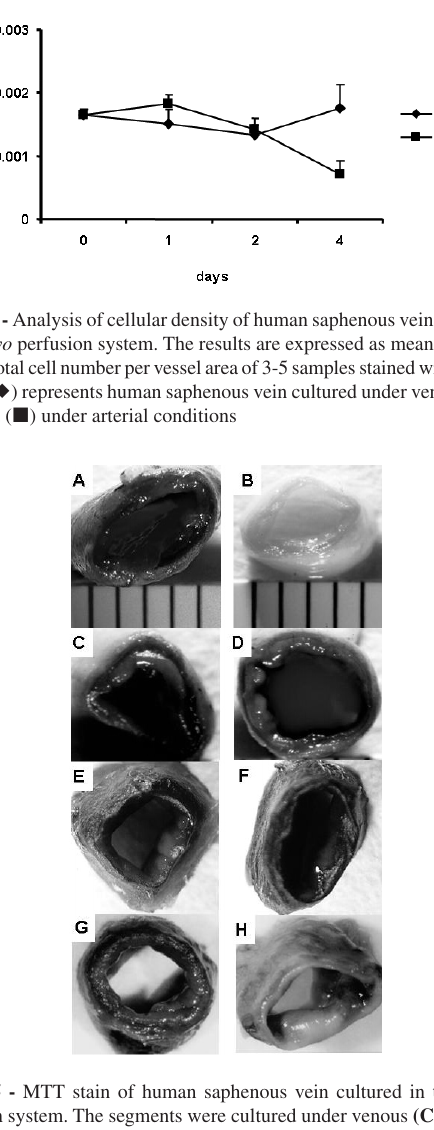
Figure 7 - Analysis of apoptosis in human saphenous vein cultured in the ex vivo perfusion system. The results are expressed as mean ± standard error of percentage of TUNEL-positive cells of 3-5 samples. (  ) represents human saphenous vein cultured under venous conditions and (  ) under arterial conditions. * indicates p < 0.05 vs. venous